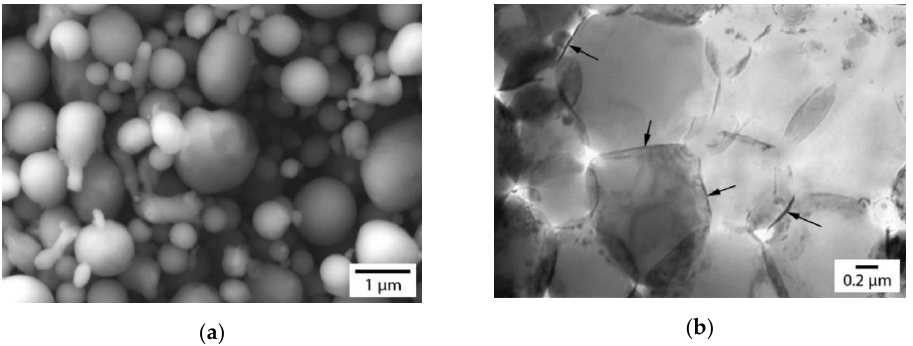
Figure 1. Electron microscopy micrographs of Al 1080 powder: ( a ) loose micron range powder (SEM); ( b ) compacted Al 1080 powder, using cold isostatic pressing (CIP) at 100 MPa (bright field TEM).